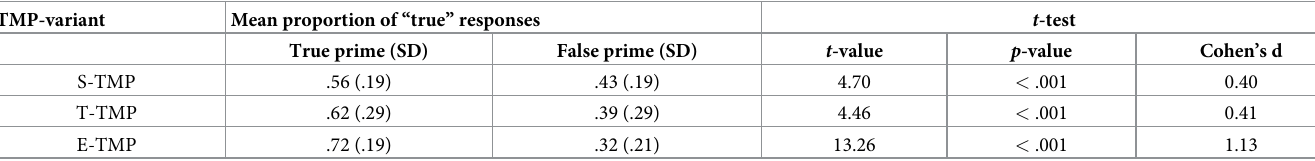
Table 2. Results (t-tests) for each of the three TMP variants from Experiment 2.